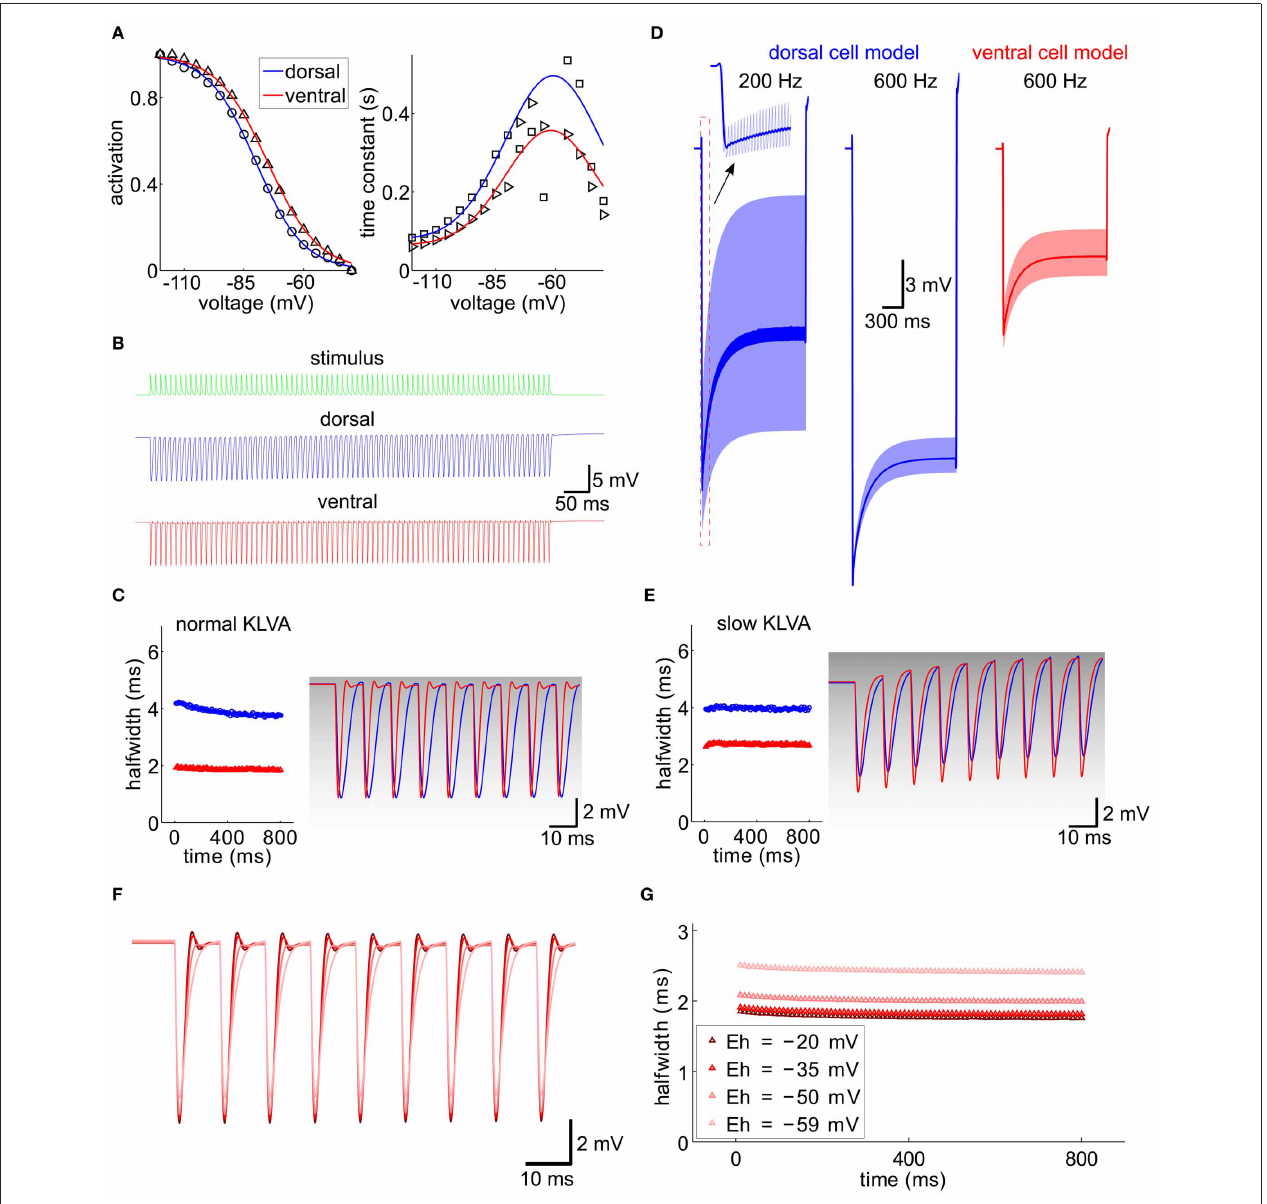
(D) Voltage responses (light colors) for different stimulus frequencies (as indicated) and model cells (colors). The dark traces were generated by low-pass filtering the voltage trace with a second-order Butterworth low-pass filter with cut-off frequency of 100Hz. (E) Same as (C) for a K LVA model with 100-fold slowed down activation and inactivation time constants. Conductances for I h and I K − LVA were adjusted to match the input resistances and equilibrium potential of the cells in (C) . (F) IPSP trains for different reversal potentials of I h (color code see G ). (G) Half-widths of the IPSP trains from (F)